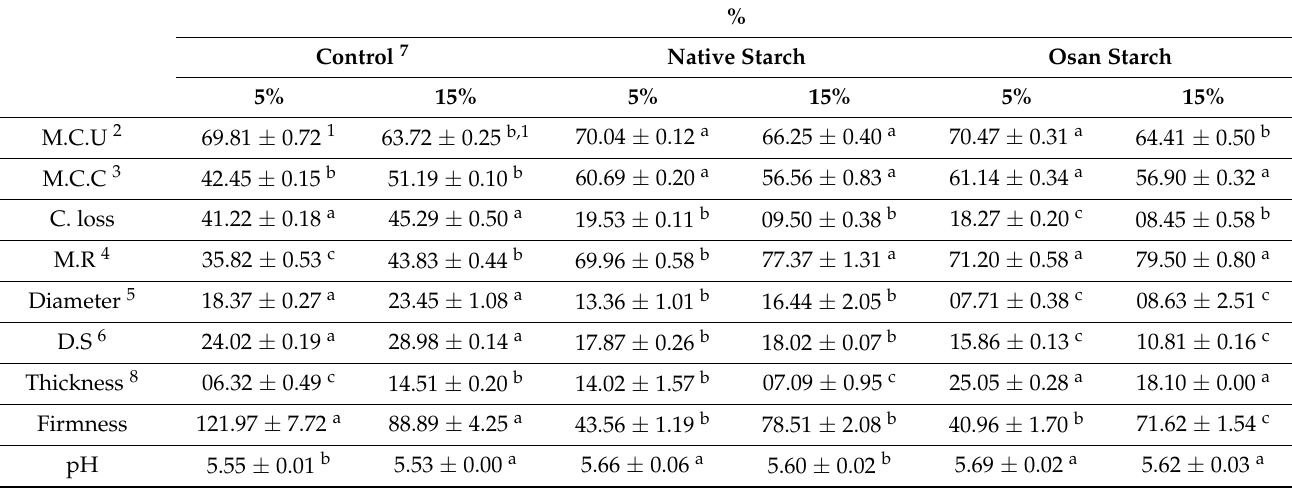
Table 1. The effect of 5 and 15% native, octenyl-succinylated (Osan) corn starch, and 5% animal fat on the physiochemical characteristics of beef